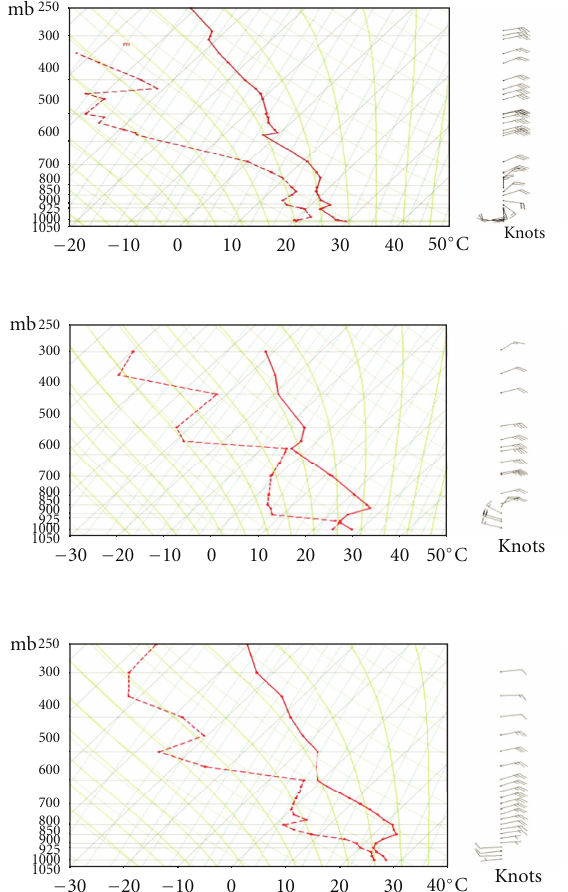
Figure 11: Rawindsonde of temperature and dewpoint and wind profiles (kts) for Tambacounda at 1200 UTC on 10 September, Dakar at 0000 UTC on 11 September, and Kawsara at 0530 UTC on 11 September 2006. The solid line is temperature, the dashed line is dewpoint, and both are given in degrees C. The soundings are plotted every 50